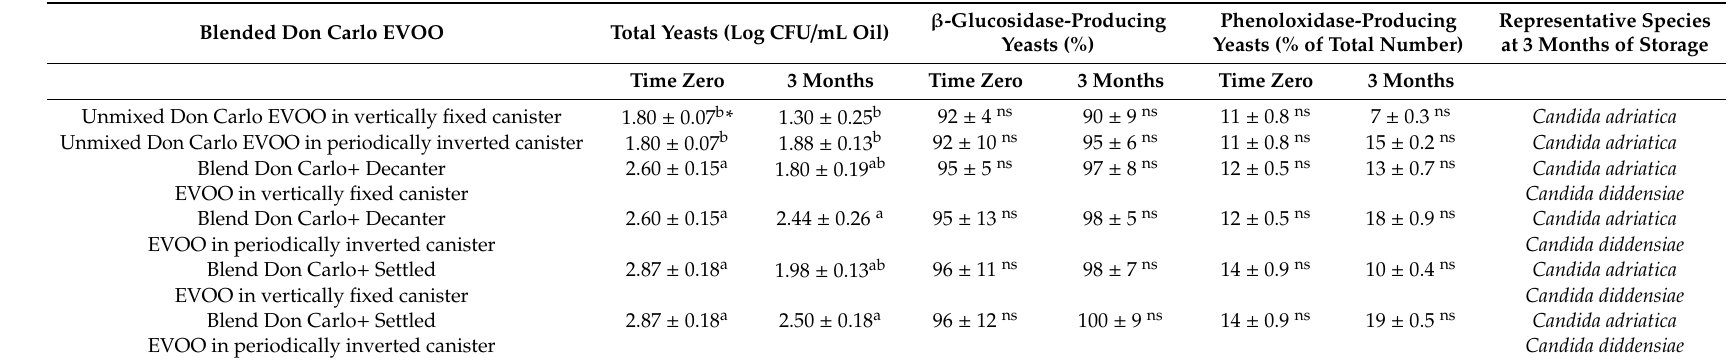
Table 3. Microbiological and enzymatic analyses of Don Carlo EVOO blended with decanter or settled Leccino mixer EVOO.